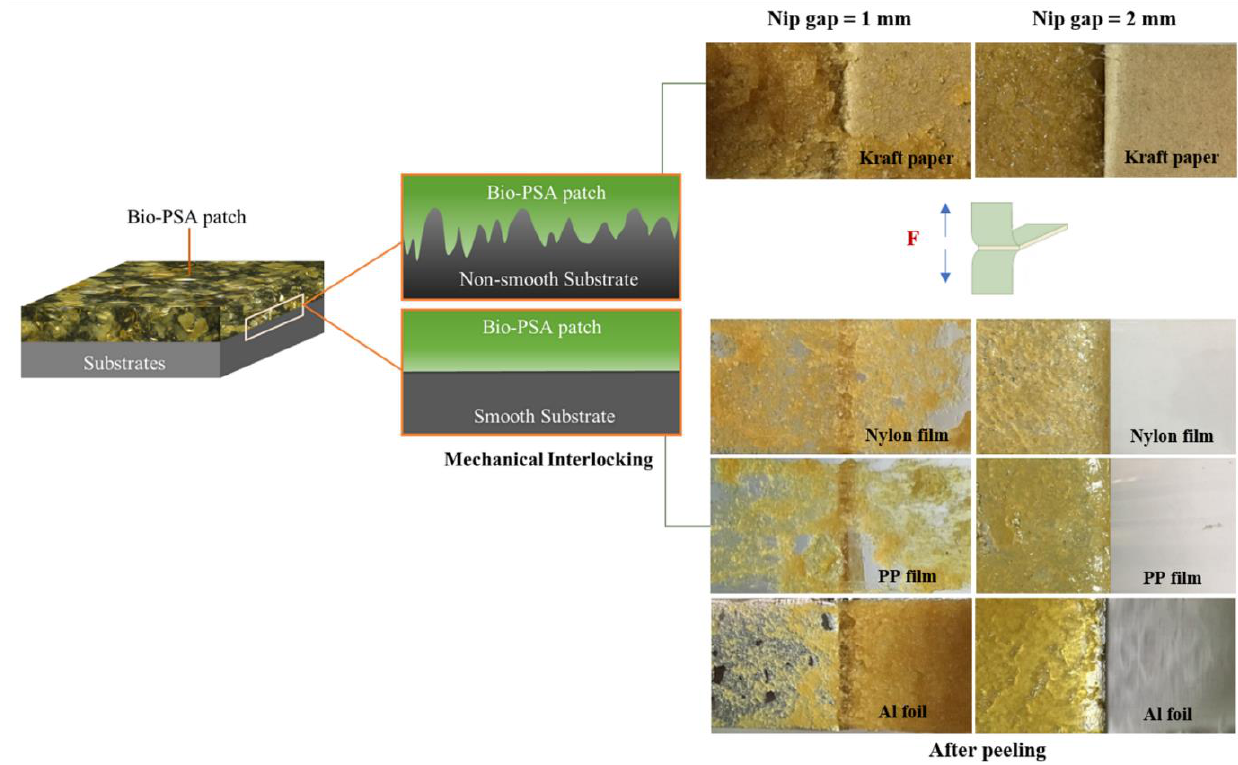
Figure 3. Adhesion model of mechanical interlocking in case of NR-PSA/CO with smooth and non-smooth surfaces along with the physical appearance of the substrate surfaces after peeling. NR-PSA/CO was produced using 20 phr of XG + 0.06 phr of CO with a mastication time of 10 min for 1 and 2 mm nip gaps .